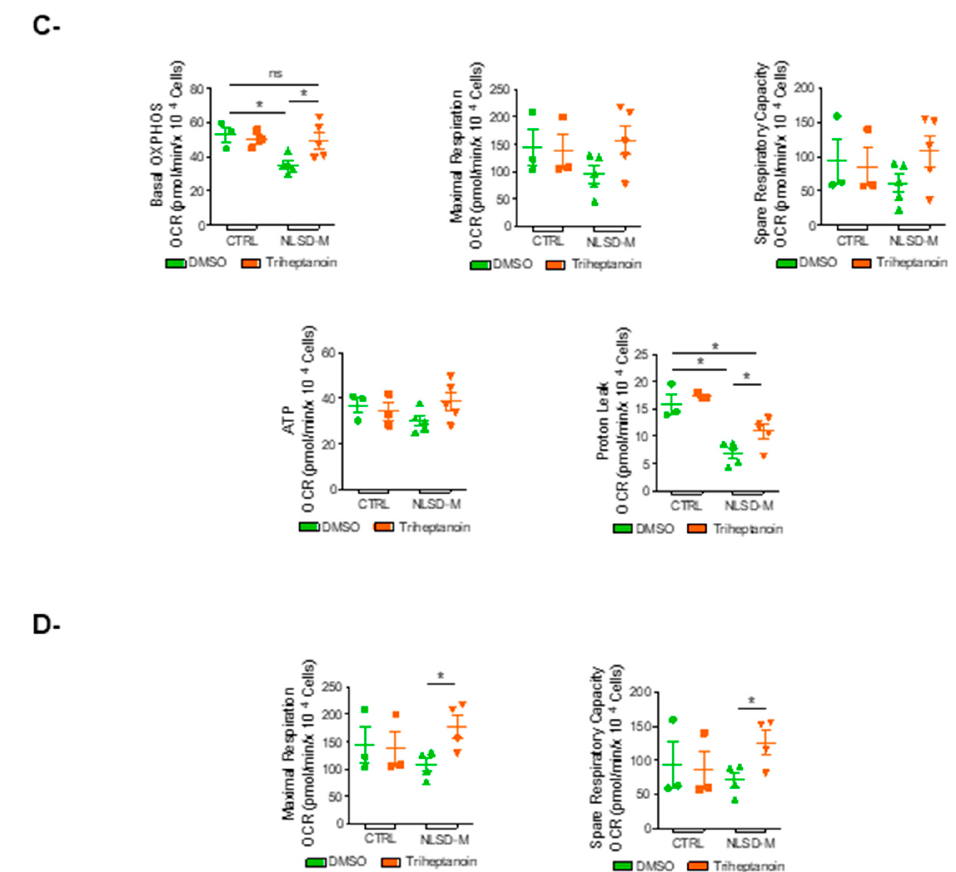
Figure 1. Mitochondrial respiration of fibroblasts treated with triheptanoin. Profile of the mitochon- drial activity measured in ( A ) NLSD fibroblasts. The colored frames represent the equivalent areas to calculate basal respiration (BR), proton leak (PL), maximal respiration and non-mytochondrial oxygen consumption (NMO 2 C) values. ( B ) normal fibroblasts. The histograms represent basal respiration, maximum respiration, mitochondrial ATP, Proton Leak and Spare respiratory capacity. Data are presented as mean ± SD. ( C ) comparation of mitochondrial respiration parameters between controls (CTRLs) and NLSD-M samples. ( D ) Comparison of Maximal Respiration and SRC between CTRLs and NLSD-M with ATGL residual activity. Statistical significance was evaluated through